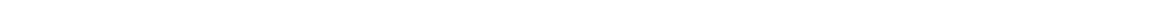
Figure 3 | asb2b functions cell autonomously in cardiomyocytes. ( a ) Schematic representation of the transplantation experiments. ( b ) Three-dimensional images of 50 hpf chimeric atria. Tg(myl7:LIFEACT-GFP);Tg(myl7: nDsRed2) WT or Tg(myl7:LIFEACT-GFP ) asb2b mutant donor cells were transplanted into Tg(myl7:LIFEACT-tdTomato ) WT host embryos. WT donor cardiomyocytes show integration of the myofilaments into WT hearts (arrows), whereas those from asb2b mutants fail to meld into WT hearts (arrowheads). Myofilament thickness was measured in 50 hpf WT and asb2b mutant donor cardiomyocytes ( n ¼ 32 (WT) and 22 (mutant) myofilament from 5 hearts). ( c ) Three-dimensional images of 96 hpf chimeric atria. asb2b mutant cardiomyocytes in WT hearts fail to integrate their myofilaments with those of adjacent cardiomyocytes. WT host cardiomyocytes appear to establish their myofilaments underneath asb2b mutant cardiomyocytes (arrows). Myofilament thickness was measured in 96 hpf WT and asb2b mutant donor-derived cardiomyocytes ( n ¼ 39 (WT) and 26 (mutant) myofilament from 5 hearts). ( d ) Three-dimensional images of 50 hpf chimeric atria resulting from transplanting WT or asb2b mutant cells from Tg(myl7:ras-GFP ) donors into Tg(myl7:MKATE-CAAX ) WT hosts. asb2b mutant cardiomyocytes exhibit abnormal membrane protrusions (arrowheads). Number of WT and asb2b mutant donor-derived cardiomyocytes exhibiting membrane protrusions in 50 hpf WT hearts ( n ¼ 5 hearts, with averages taken from 30 cardiomyocytes per heart.). * P o 0.05 and ** P o 0.01 by one-way analysis of variance (ANOVA) followed by Tukey’s honest significant difference test. Error bars, s.e.m. Scale bars, 20 m